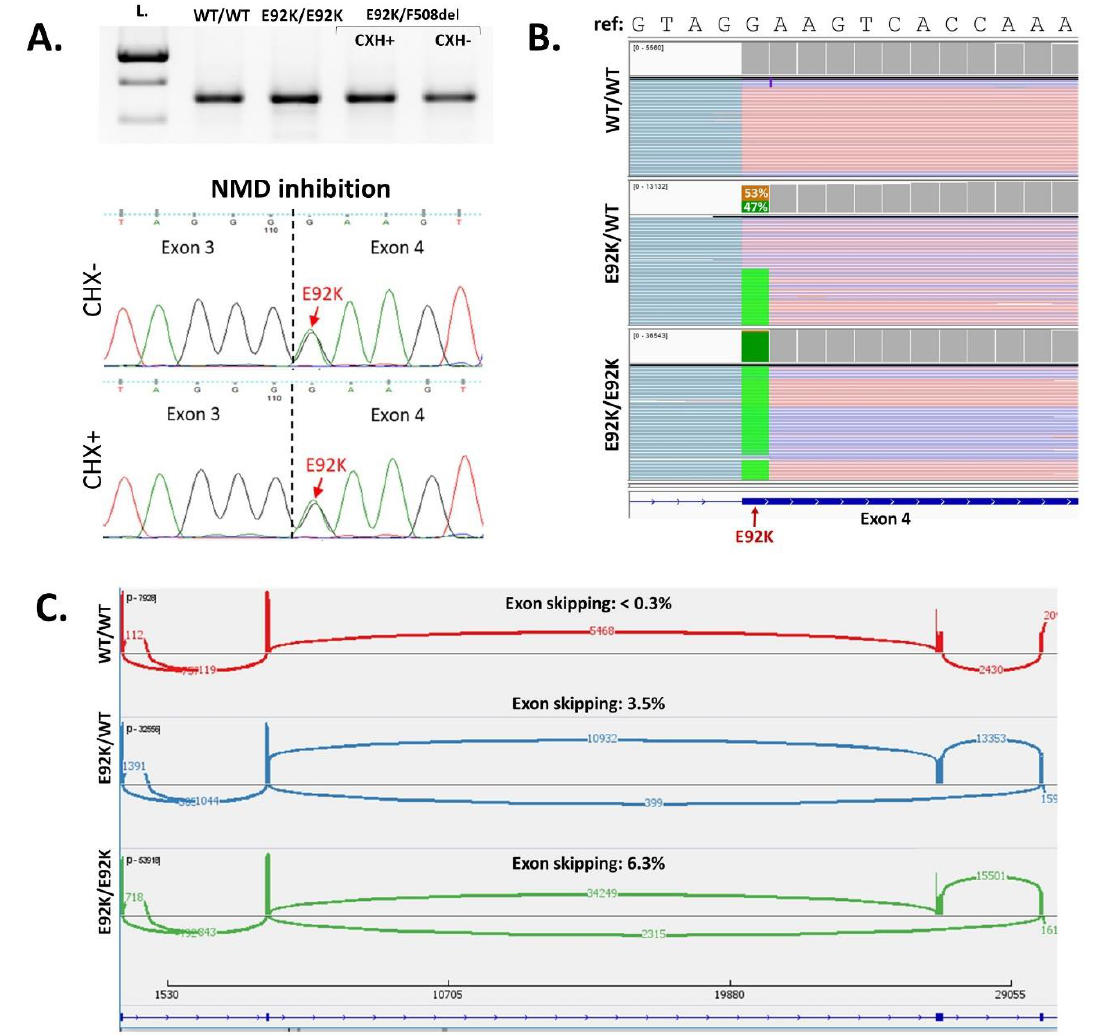
Figure 6. ( A ) Electrophoregram of RT − PCR products and sequencing of RT − PCR products obtained from intestinal organoids sample of heterozygous E92K/F508del patient before and after NMD inhibition; ( B , C ) targeted next − generation sequencing of PCR products covering CFTR exons 2–6 obtained from intestinal organoids samples of healthy control, E92K homozygous patient and healthy carrier of E92K variant; ( B ) analysis of nucleotide coverage around the E92K variant in the IGV browser. For each sample, the nucleotide coverage is presented above. Examples of the reads are depicted below; for the E92K/WT sample, the percentage of reads with each allele is shown; ( C ) analysis of splicing events using Sashimi plot in IGV